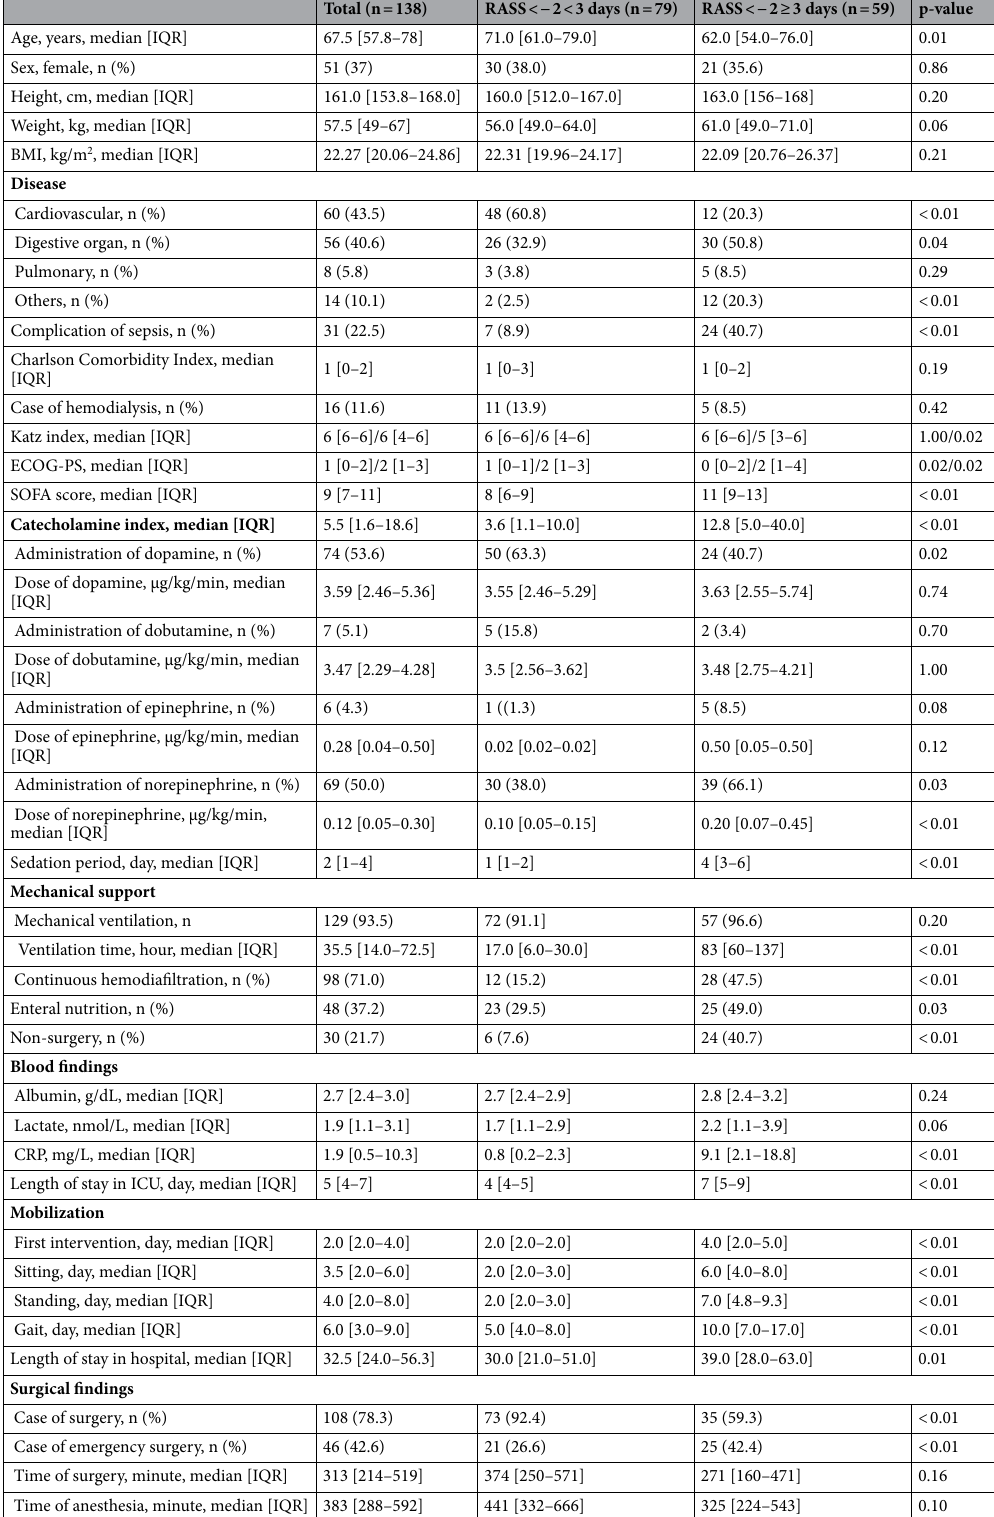
Table 1. Characteristics. IQR interquartile range, n number, BMI body mass index, ECOG-PS The Eastern Cooperative Oncology Group Performance Status, SOFA Sequential organ failure assessment, CRP C-reactive